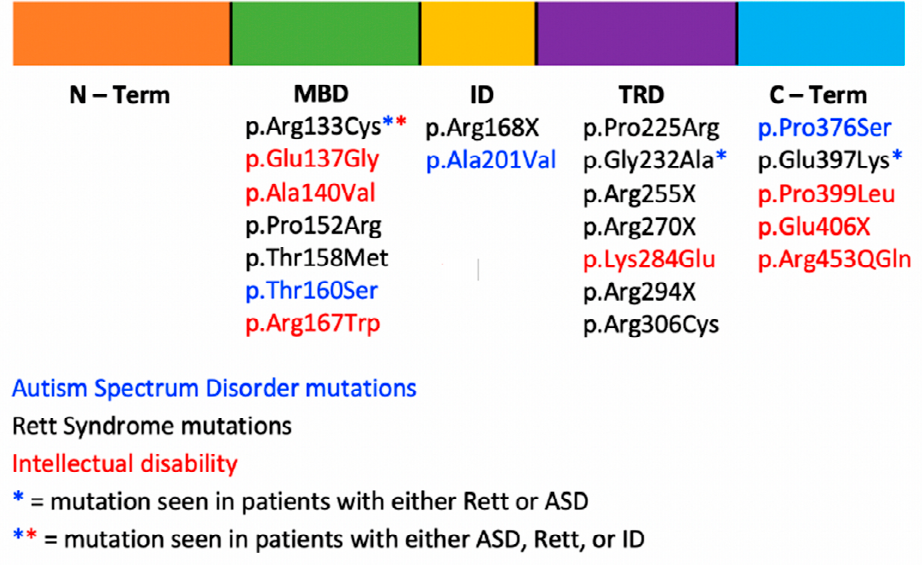
Figure 1. Schematic of the MECP2 protein showing phenotypic variability among pathogenic variants and their associated disorders.